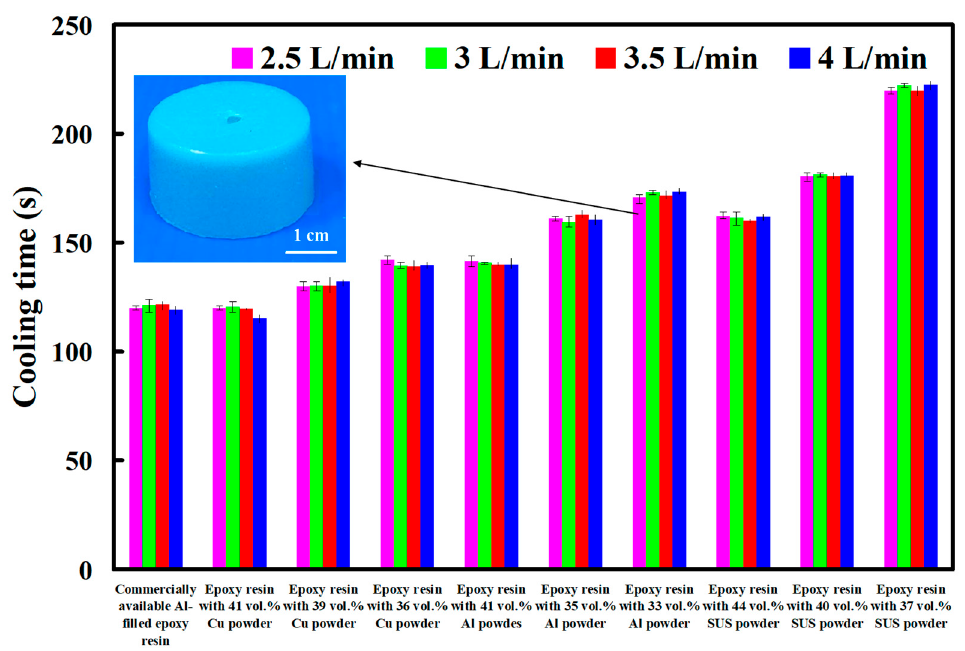
Figure 16. Cooling time of injection molded parts fabricated by ten sets of injection molds cooled with different cooling water flow rates.